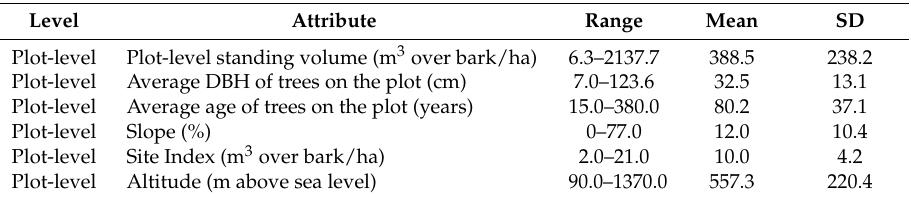
Table A4. Characteristics of continuous variables of training set B (8997 plots).